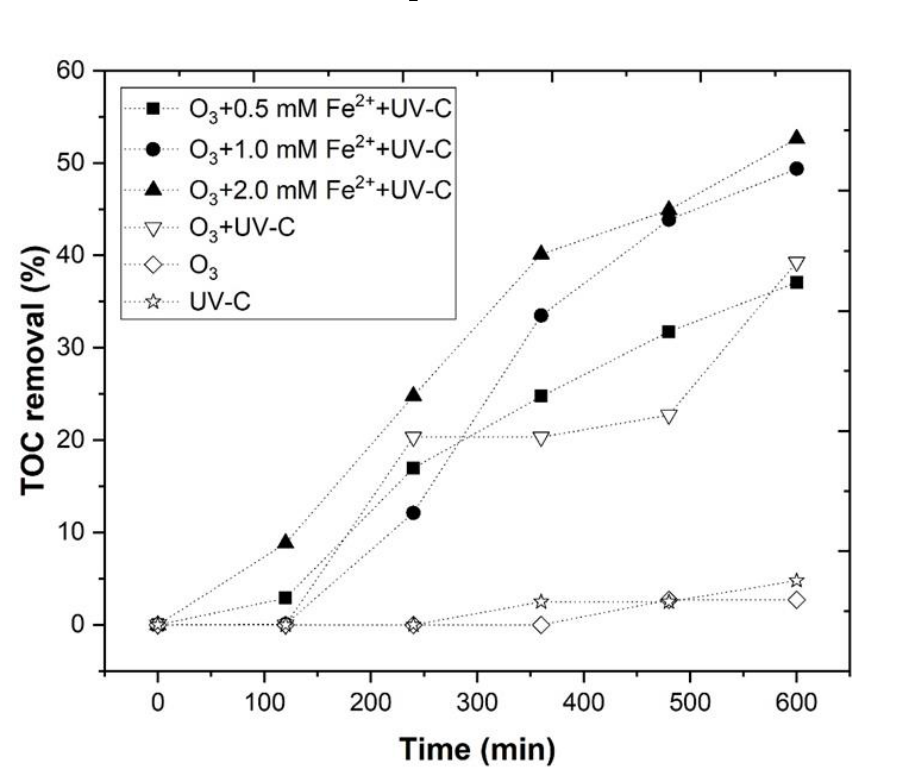
Figure 7. Evaluation of TOC removal through the O 3 /Fe 2+ /UV-C process at different Fe 2+ concentrations (0.5–2.0 mM). Ozonation experimental conditions were as follows: pH = 4.0, ozone flow rate 5 mg/min, air flow 1.0 L/min, agitation 350 rpm, time 600 min, radiation UV-C mercury lamp (254 nm). Blank experiments (O 3 /UV-C, O 3 , and UV-C—pH 4.0) are also shown as a reference. After 600 min of reaction, an Fe 2+ concentration of 1.84, 12.60, and 41.92 mg